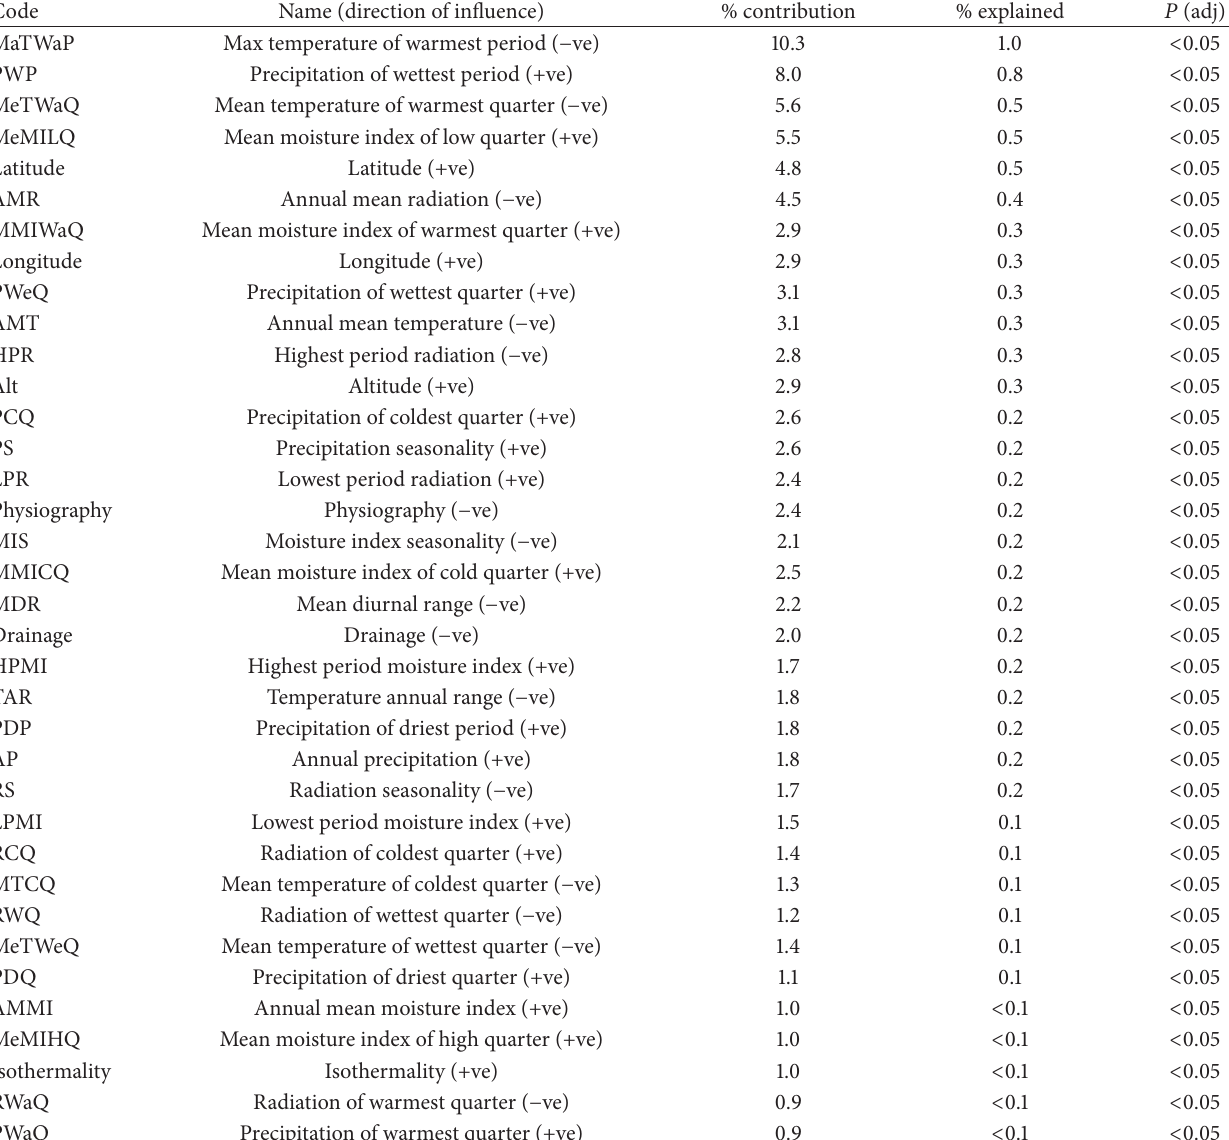
Table 1: Codes and descriptions of significant variables ( 𝑃 ≤ 5 %) listed in order of decreasing importance (contribution) from forward selection in canonical correspondence